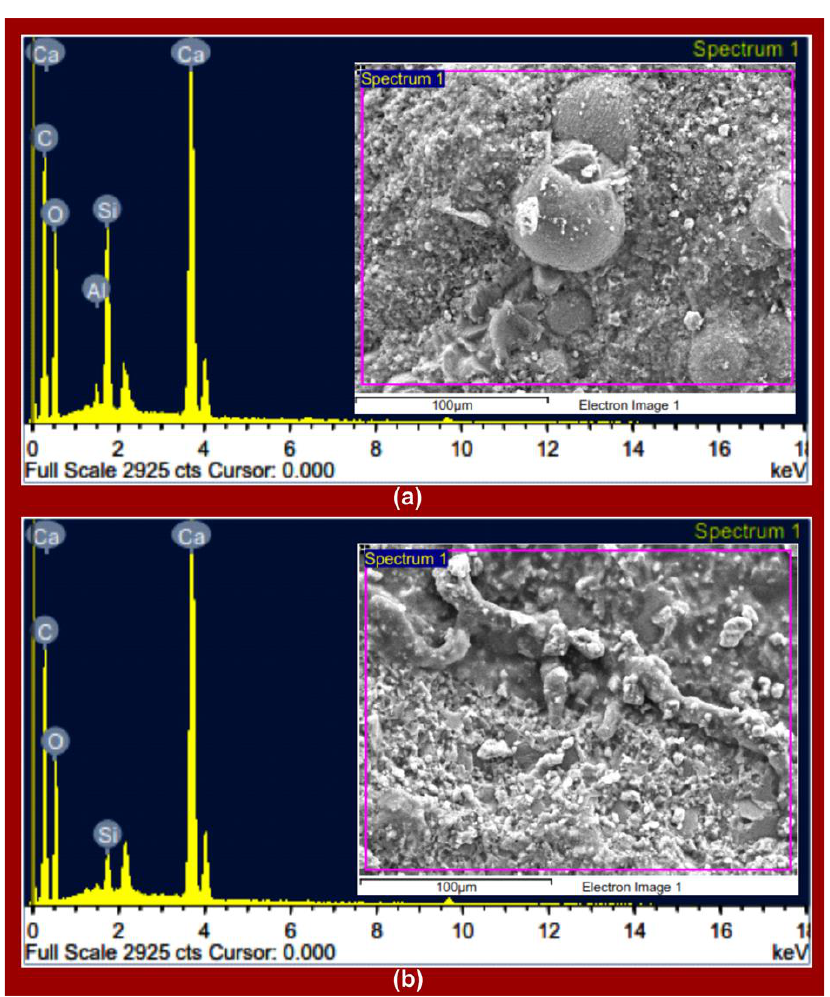
Figure 6. EDX analyses of ( a ) Eagle Ford shale and ( b ) Wolfcamp shale, with indications of peak intensities associated with detected elements.